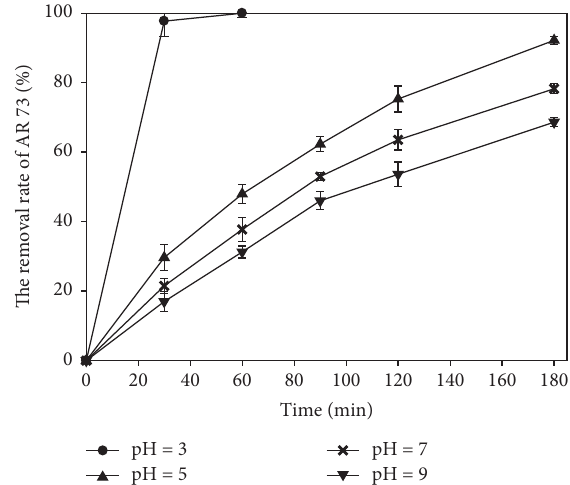
Figure 3: Effect of initial pH on the adsorption of acid red 73 by rice wine lees.